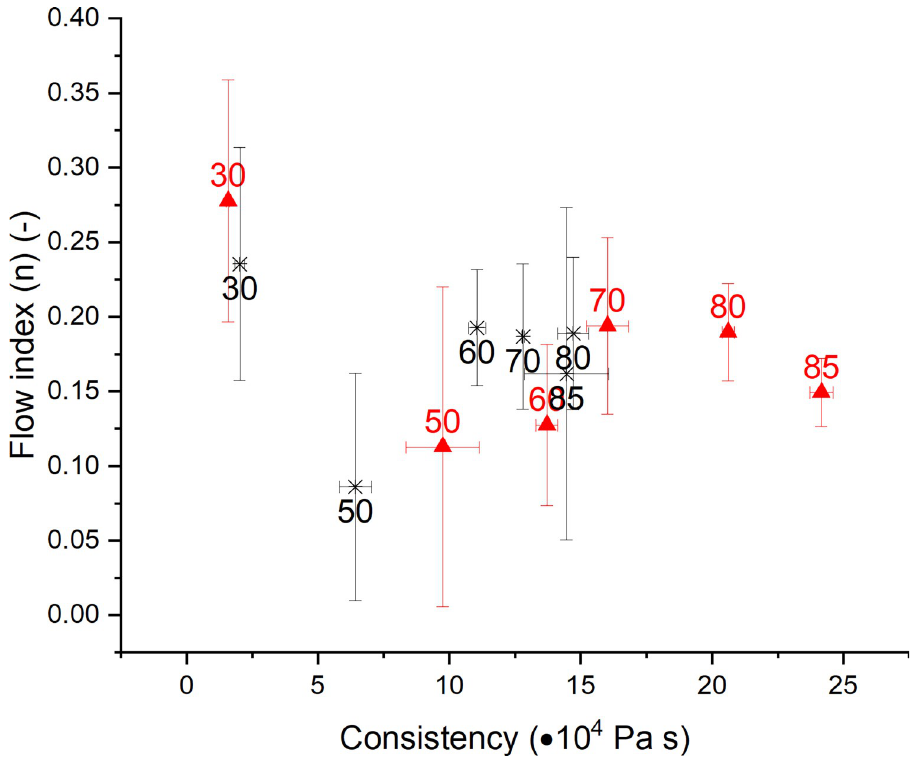
Fig 4. Impact of fermentation and heating on the flow index and consistency for ε yeasted wheat dough and ( ▲ ) yeasted wheat dough (1 g fresh yeast/100 g flour). The numbers in each value represent the related treatment temperature of the sample. Data of different dough systems is not quantitatively comparable, as the mass varied between the different dough systems in order to reach comparable strain—strain rate combinations. (n = 3, � X � ±